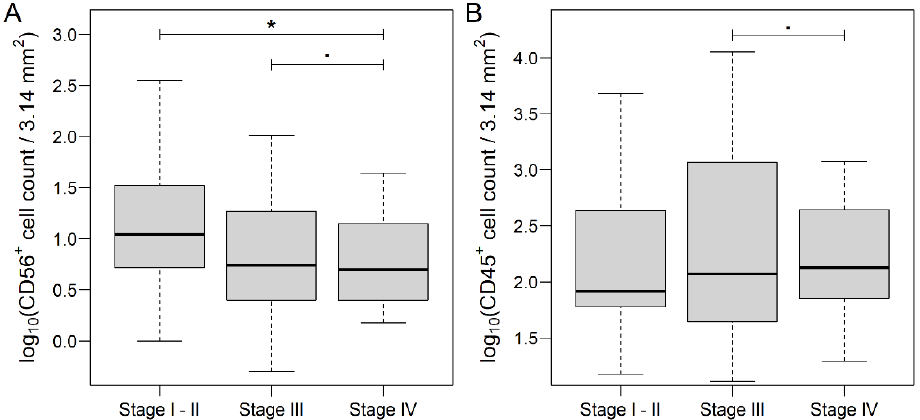
Figure 4. CD56 ( A ) and CD45 ( B ) count data of liver metastasis samples of colorectal cancer patients, grouped by AJCC staging [9]. CD56 count was significantly lower in those samples, where the metastasis was present at the time of tumor diagnosis simultaneously, while the opposite tendency was found in the case of CD45 counts. The thick line represents the median value. * p < 0.05 and ∙ 0.1 < p ≤ 0.05.